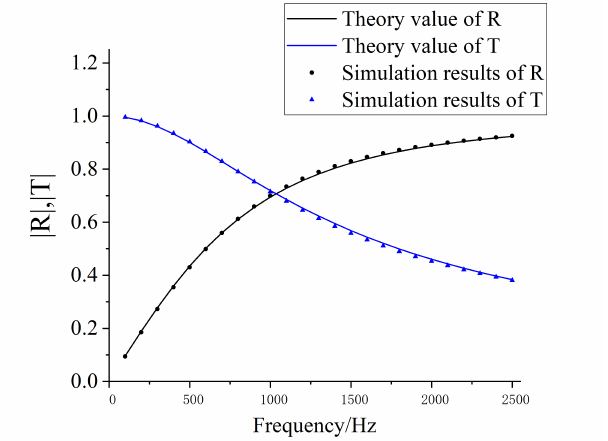
Figure 12. Comparison of the theoretical and the simulation values of reflection coefficient (R) and transmission coefficient (T), when there is no sample in the impedance tube.